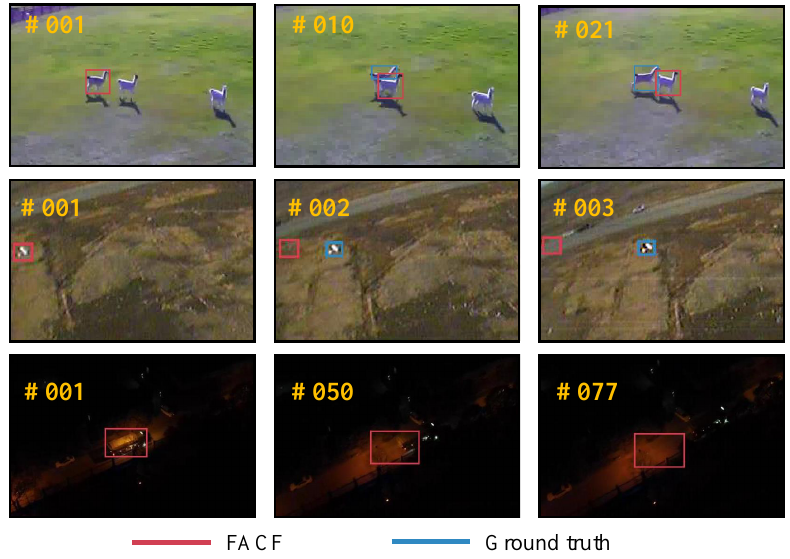
Figure 11. Some representative tracking failure cases of the proposed FACF tracker. From top to bottom: Animal3, uav1_3, and sand truck from DTB70 [25], UAV123_10fps [26], and UAVTrack112 [27],